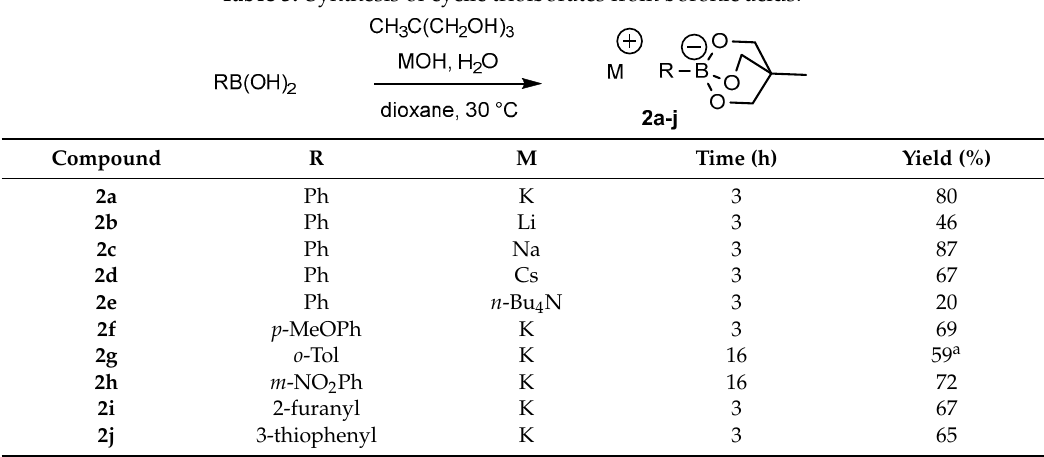
Table 3. Synthesis of cyclic triolborates from boronic acids.